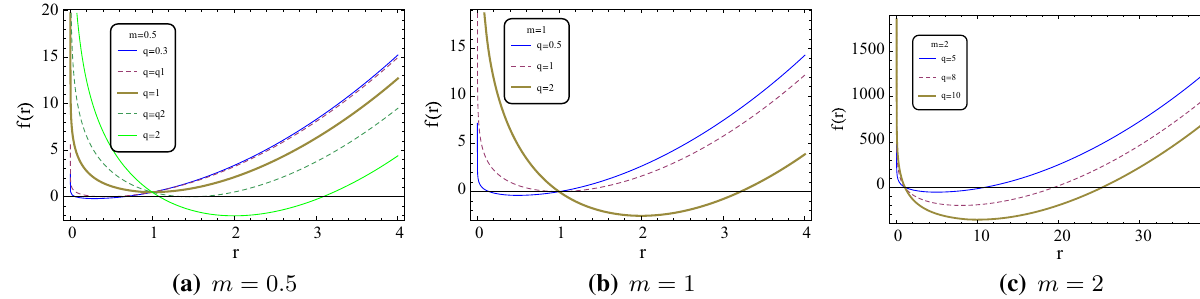
Fig. 2 The behaviors of f ( r ) for different values of q when m = 0 . 5, 1 and 2